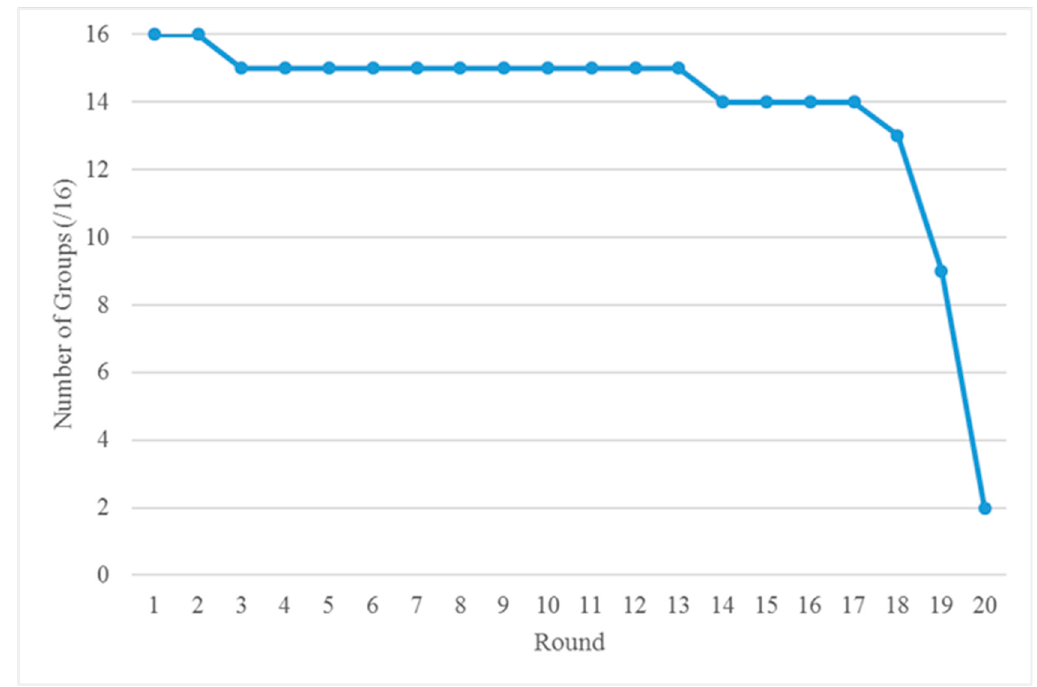
Figure A1. Number of groups (/16) with a positive stock at the end of each round. Games 2018 , 9 , x FOR PEER REVIEW